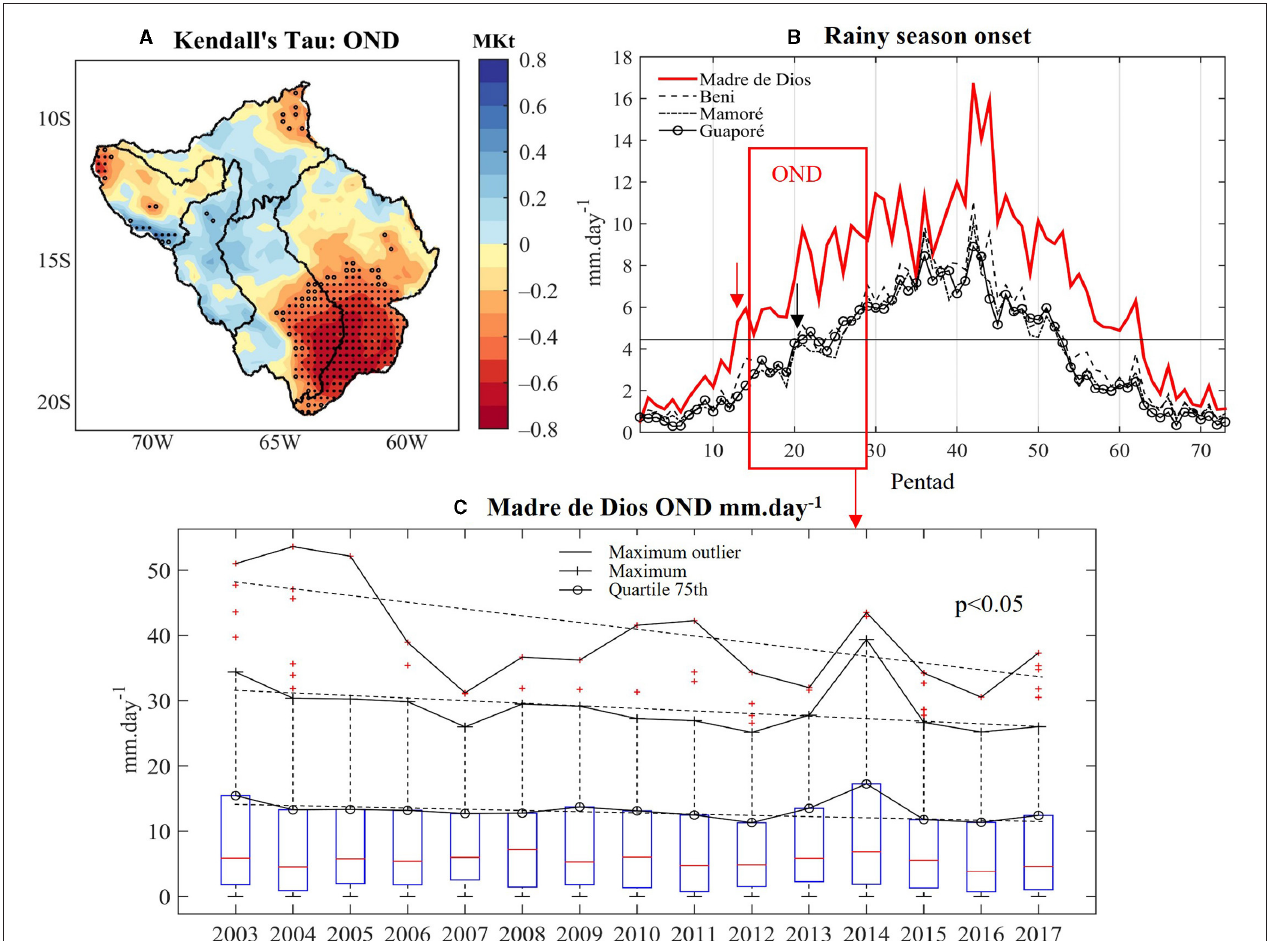
FIGURE 7 | (A) As Figure 6A for October to December (OND); (B) mean annual rainfall cycle (2003–2017) for each sub-basin in pentad. Black horizontal line stands for the mean pentad for the Upper Madeira Basin (4.26mm.day − 1 ); the onset of rainy season is indicated by red arrow for the Madre de Dios sub-basin (around mid of September) and in black for the Beni, Mamoré, and Guaporé (around mid of October) and; (C) time evolution of the basin mean daily OND: outliers, maximum, and quartile 75th rainfall in the Madre de Dios sub-basin. The three with significative negative trends ( p <